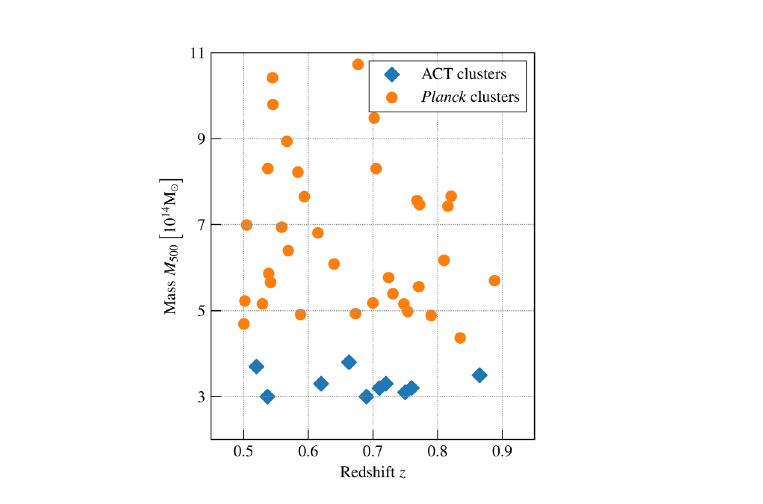
on large range of cluster masses (10 14 − 10 15 M ⊙ ) and at high redshift z > 0 . 5 for which